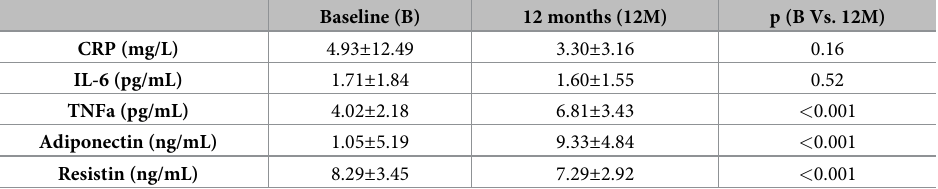
CRP: C-reactive protein, normal values: 0.07–8.2 mg/L. IL-6: interleukin-6, normal values: 3.13–12.5 pg/mL. TNFa: tumor necrosis factor alpha, normal values < 15.6 pg/mL. Adiponectin, normal values 0.8–21 ng/mL. Resistin, normal values 6.1–26.4